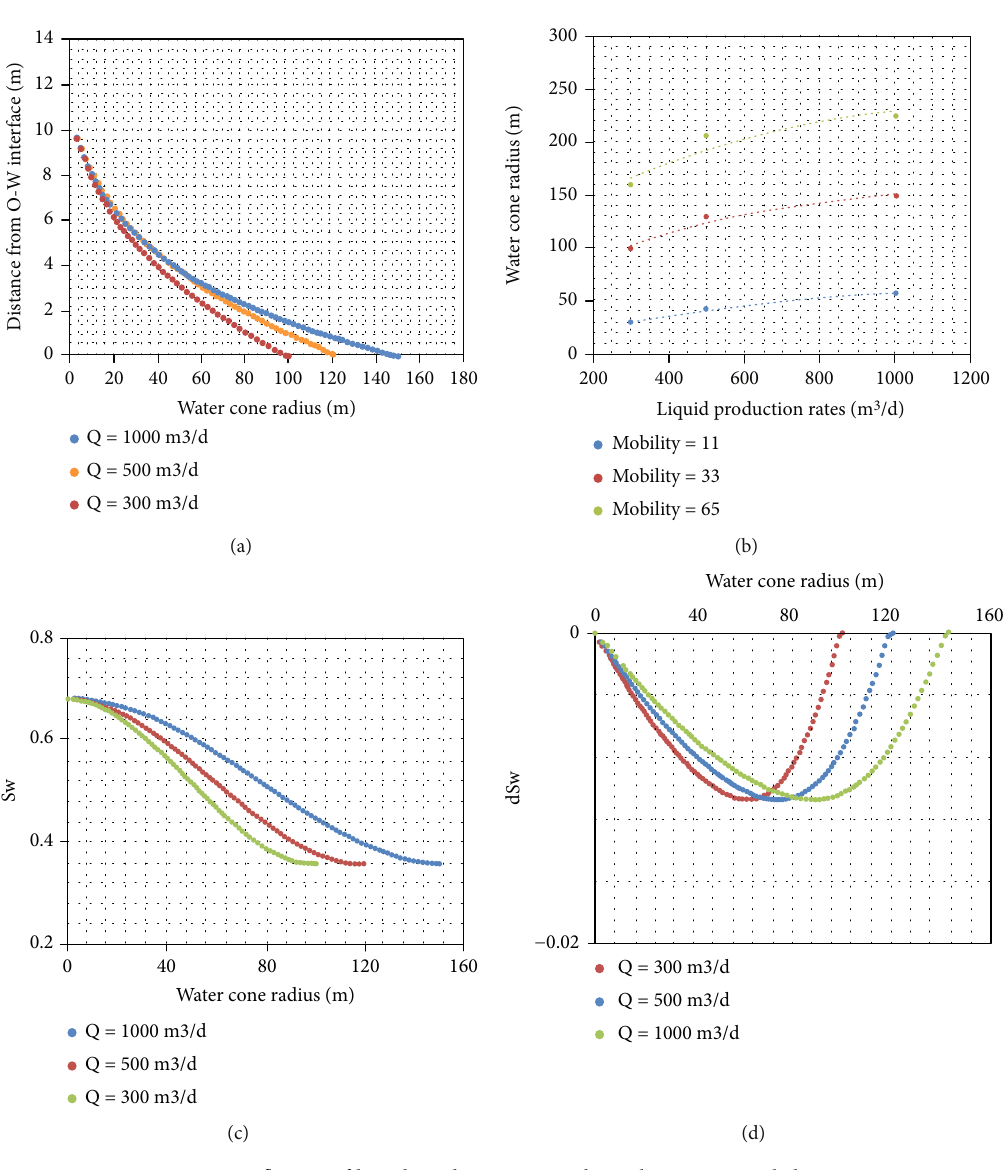
Figure 8: In fl uence of liquid production strength on the water cone behavior.